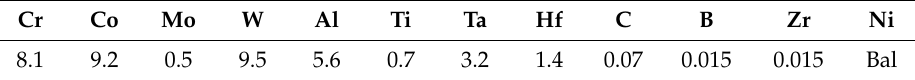
Table 1. The chemical compositions of CM247LC (in wt.%)